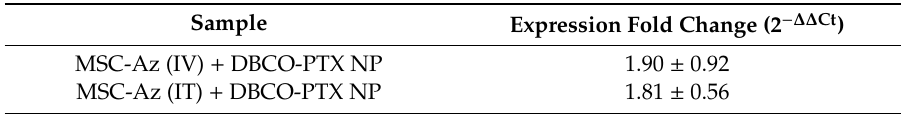
Table 3. Analysis of relative gene expression data using Real-Time Quantitative PCR. Data represents mean ± SD ( n = 4). Untreated tumors were used as blank